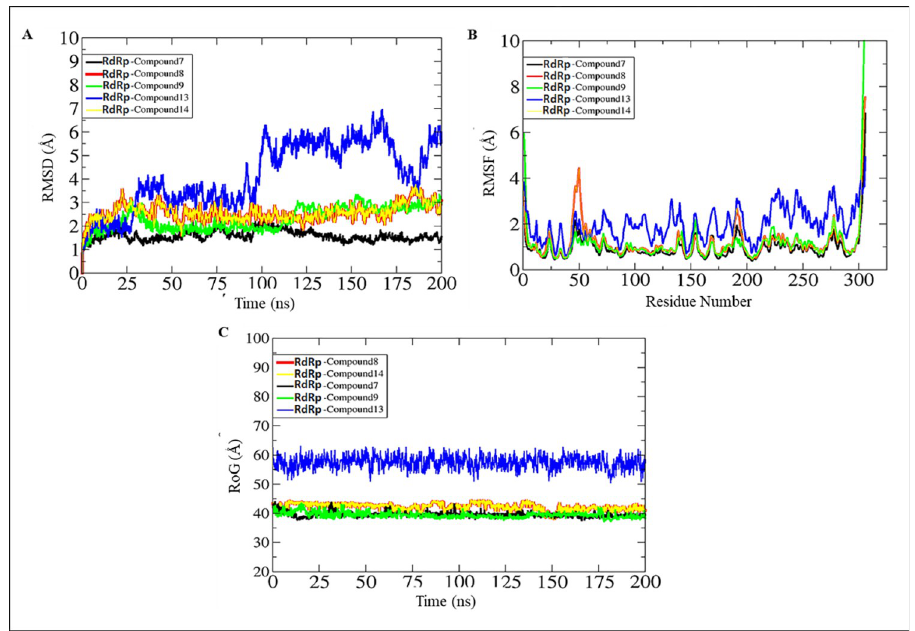
Fig 7. Backbone structural deviations. Analysis based on molecular dynamics simulations. A. RMSD, B. RMSF and C. RoG.